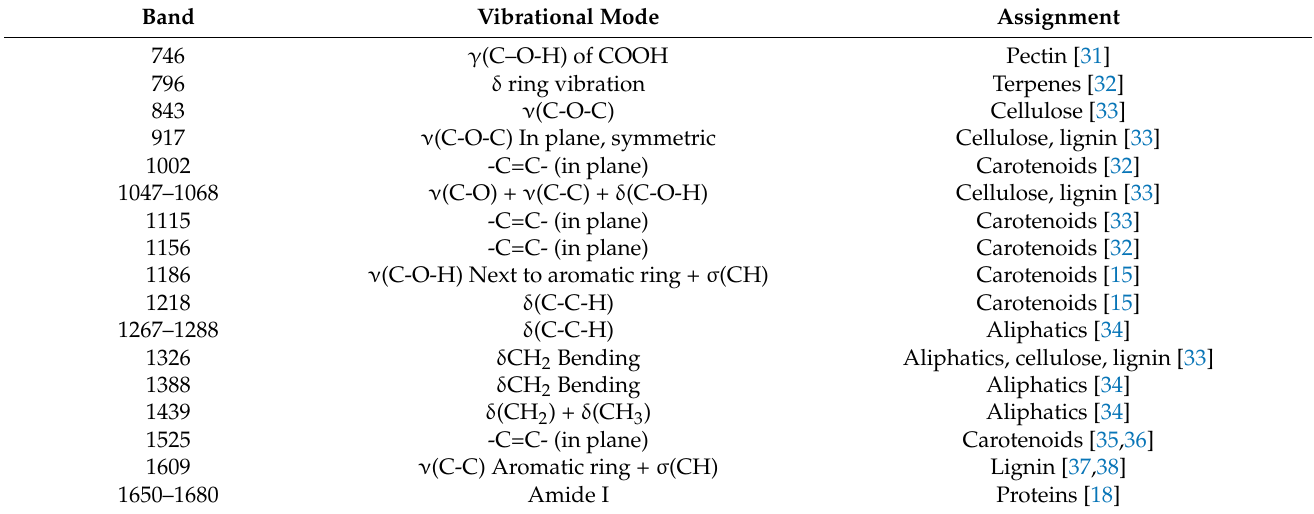
Figure 1. Averaged Raman spectra collected from leaves of male ( blue ), female ( red ), and hermaphrodite ( green ) plants. For each spectrum, 50–77 individual spectra collected from leaves of plants were averaged. Vibrational bands that correspond to certain chemicals present in the leaves are labeled and discussed in Table 1. Table 1. Assignments of vibrational bands observed in the spectra collected from the leaves of hemp